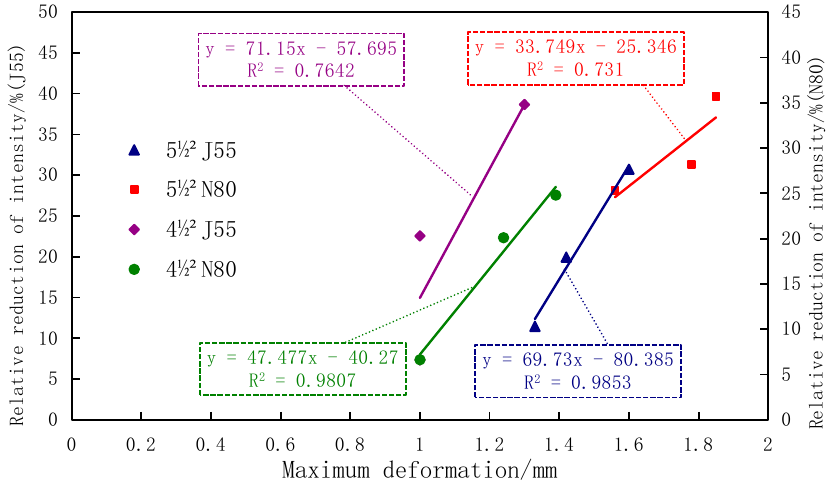
Figure 20. Relationship between relative intensity-reduction ratio and maximum deformation.